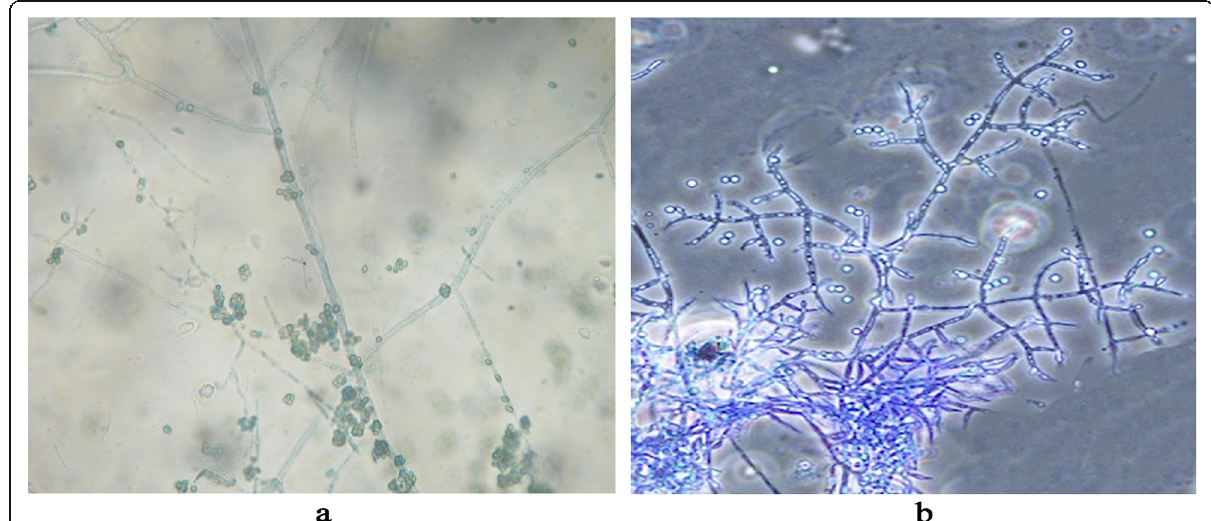
Fig. 1 Phialides and phialospores of a Trichoderma harzianum and b Trichoderma viride (taken from the Université de Bretagne Occidentale